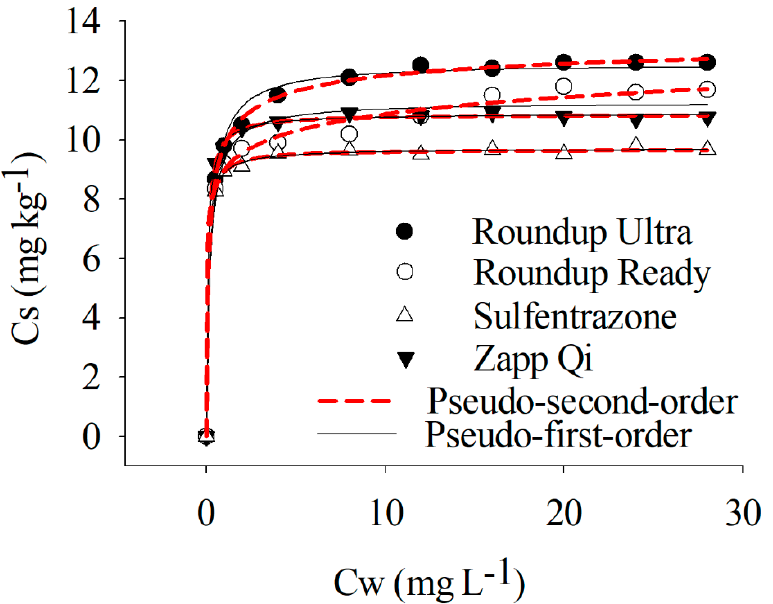
Figure 1. Estimates of the adsorption kinetics curve for sulfentrazone alone and mixed with glyphosate formulations.